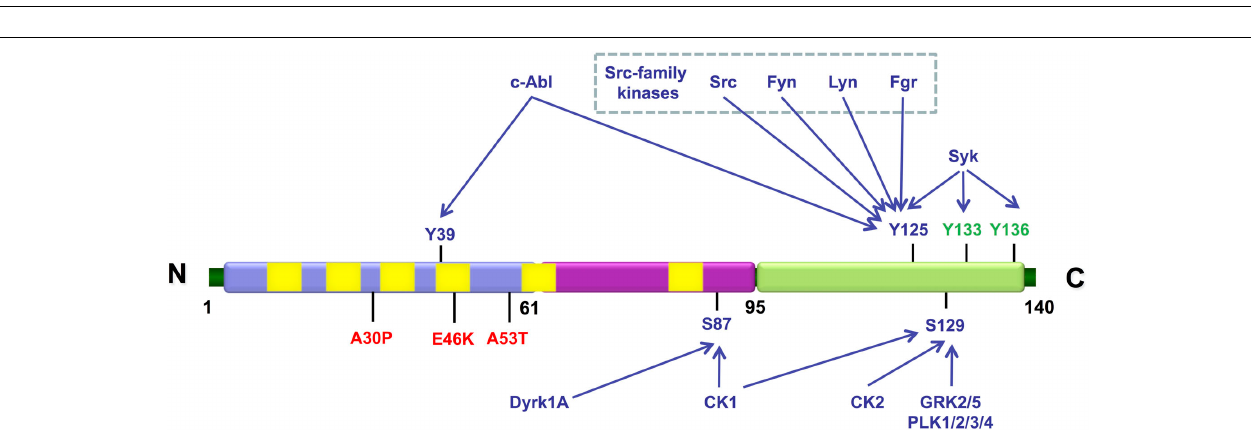
as LBs and Lewy neurites and into PHFs and NFTs. In this situation the normal cellular quality-control systems (molecular chaperones, ubiquitin proteasome system (UPS), phagosome/lysosome system) are not able to counteract and prevent or reverse protein misfolding or eliminate proteins that have misfolded or assembled into pathological aggregates and amyloid fibrils.